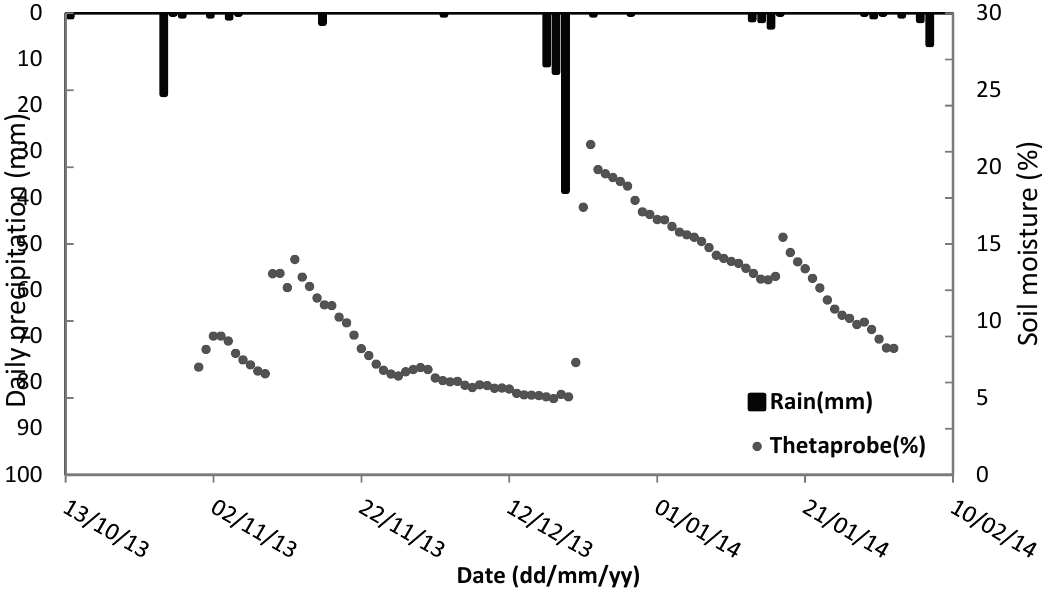
Figure 3. Daily precipitation data and surface soil moisture variations, recorded during the ground campaign with a thetaprobe at 0–5 cm